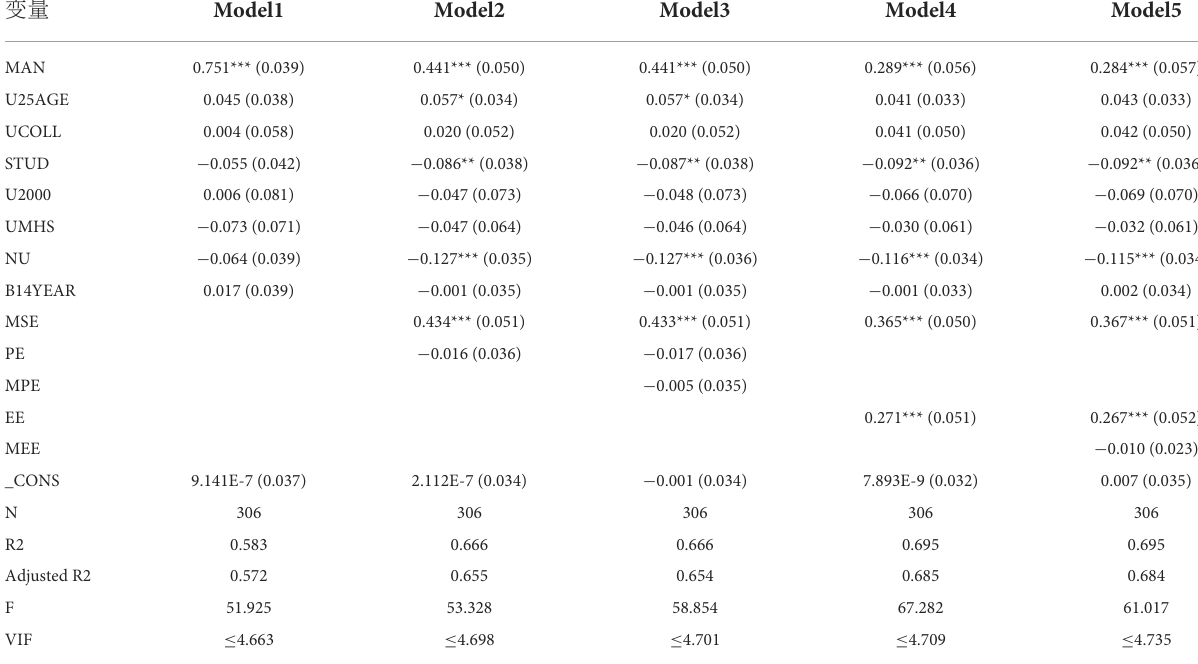
TABLE 7 Moderation effects.